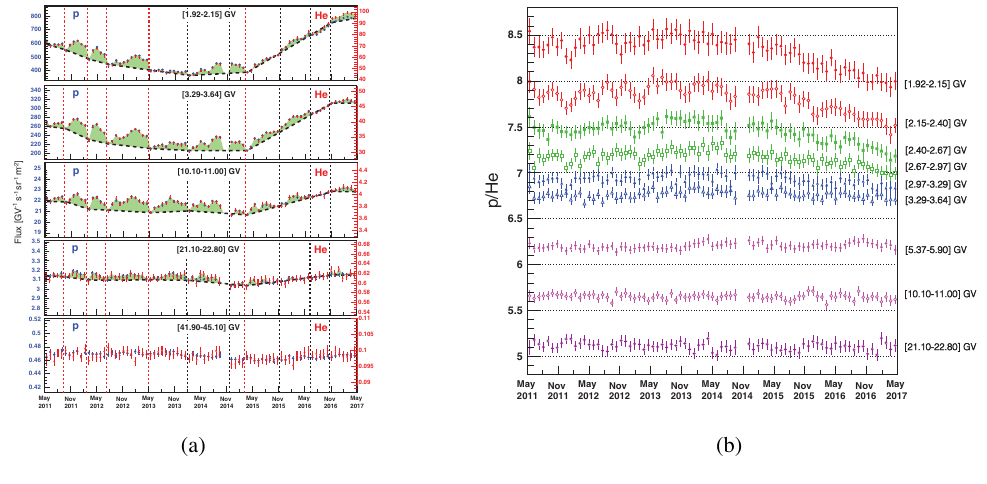
FIG.2. TheAMSproton(blue,leftaxis)andhelium(red,right Figure 2: ( a ) The AMS p (blue, left axis) and He (red, right axis) fluxes as function of time for 5 rigidity bins. axis) fluxesas function of time for 8 rigidity bins. The error bars are the quadratic sum of the statistical and time dependent The error bars are the quadratic sum of the statistical and time dependent systematic errors. Detailed structures systematic errors. Detailed structures (green shading and dashed (green shading and dashed lines to guide the eye) are clearly present below 40GV. The red vertical dashed lines lines to guide the eye) are clearly present below 40 GV. The vertical dashed lines denote boundaries between these structures denote structures that have also been observed by AMS in the e − flux and the e + flux. ( b )The AMS p / He flux ratio as function of time for 9 characteristic rigidity bins. The errors are the quadratic sum of the statistical and time dependent systematic